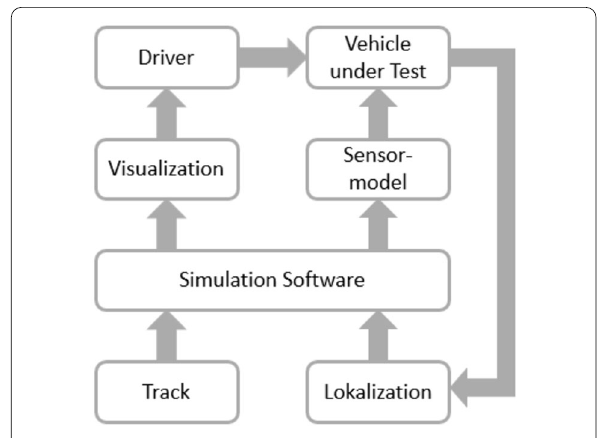
Figure 2 VIL-architecture as well as the flow of information